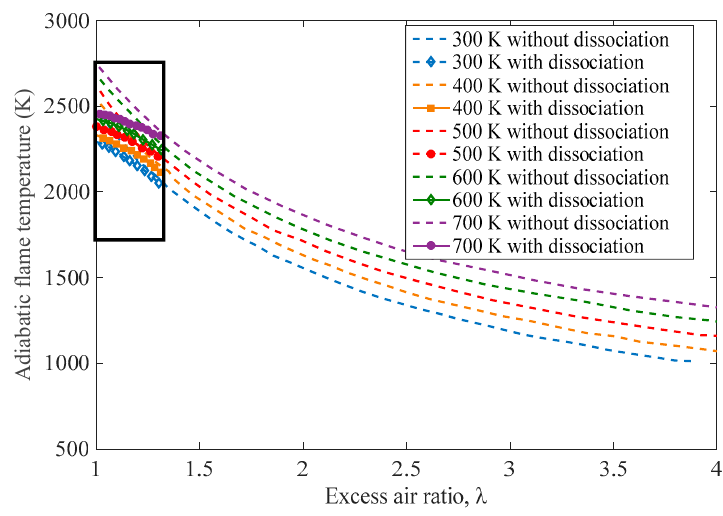
Figure 6. Adiabatic flame temperature with and without dissociation with different preheats.